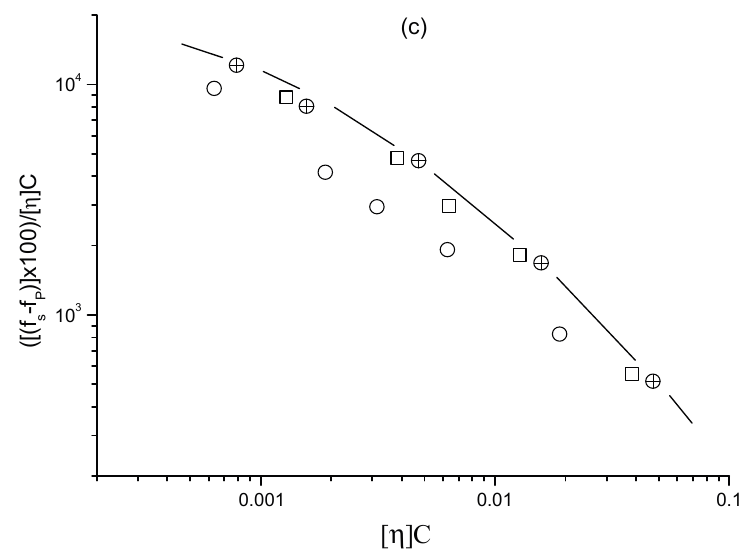
Figure 14. Drag reduction behavior of PEO polymers in 0.514 M NaCl tested by rotating disk: solvent (*); WSR-N-12K, M W = 1.7 × 10 6 ( ○ ), WSR-N-60K, M W = 4.0 × 10 6 ( □ ); WSR-301, M W = 5.3 × 10 6 ( □ ). ( a ) Friction factor versus Reynolds number for 3 ppm PEO solutions; ( b ) Friction factor versus Reynolds number at constant polymer volume fraction, [ η ] C = 0.007; ( c ) Drag reduction efficiency measured at R e = 520,000 versus PEO polymer volume fraction (Reprinted from